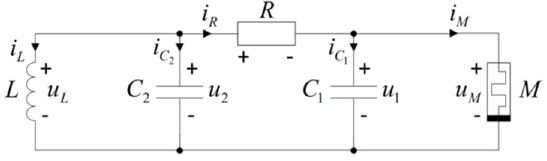
Figure 7. Schematics of the five-element chaotic circuit [19].